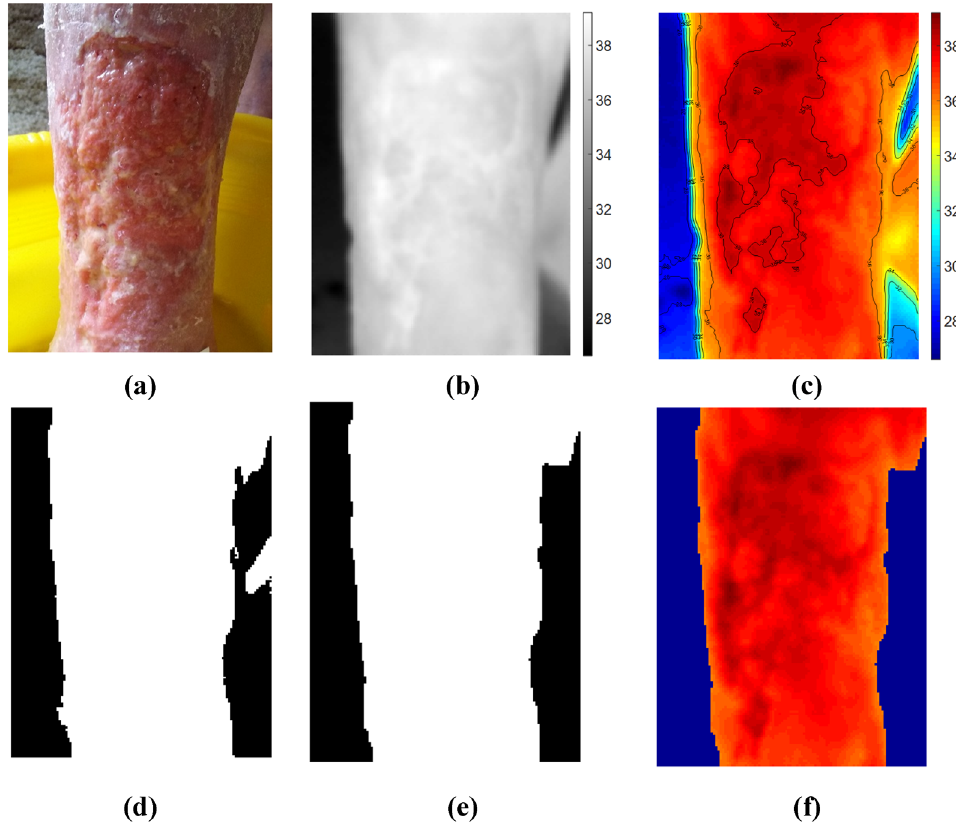
Figure 4. Thermal Image Pre-processing Steps. ( a ) RGB image ( b ) Thermal image normalization (shown in Grey scale) ( c ) Contour detection ( d ) Image masking ( e ) Enhanced mask ( f ) Masked thermal image (background